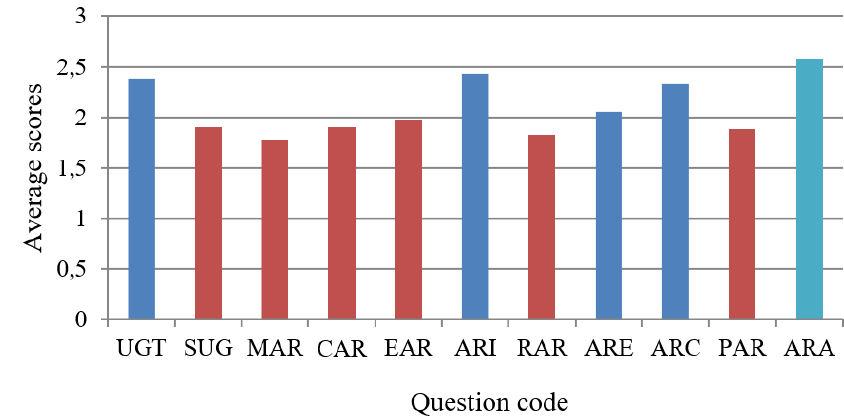
Figure 2: Distribution of